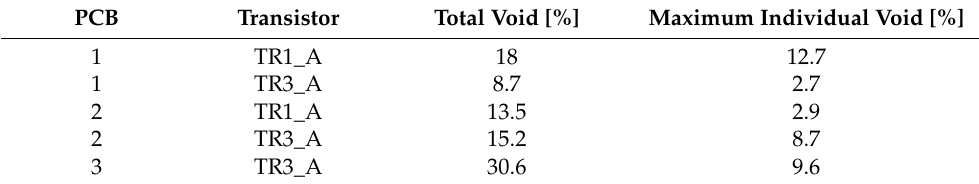
Table 1. Voids sizes for the investigated RF power